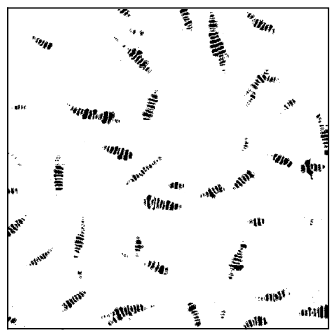
Figure 7. Two-dimensional atomic force microscopy (AFM) images of original and foamed asphalt binders at different moments: ( a ) 0% – 0 min; ( b ) 3% – 105 min; ( c ) 3% – 210 min.